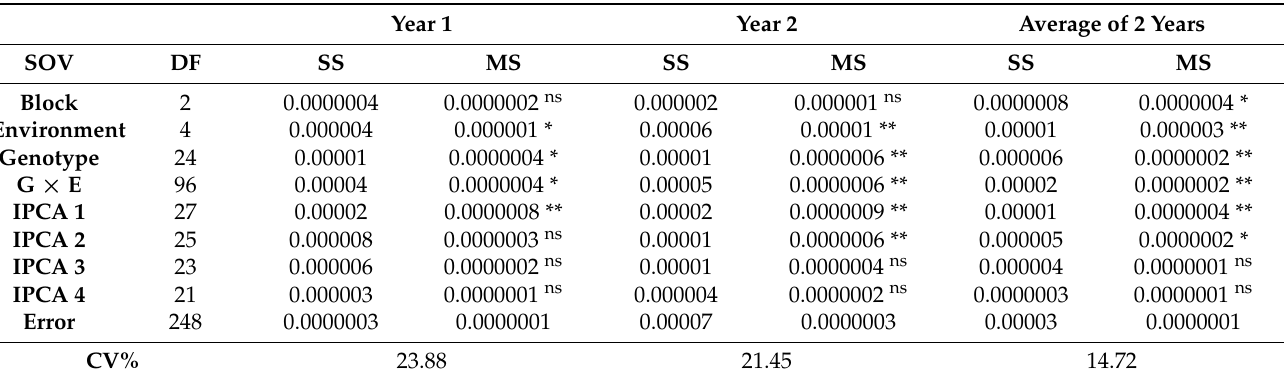
Table 3. Variance analysis based on AMMI model on 25 wheat genotype in five regions in the first, second, and average of two crop years.